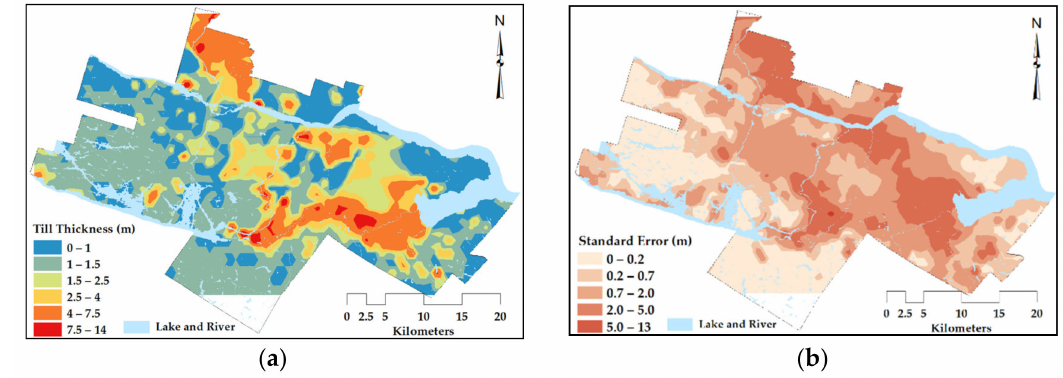
Figure 11. ( a ) Till thickness map and ( b ) kriging standard deviation, (cid:101) σ